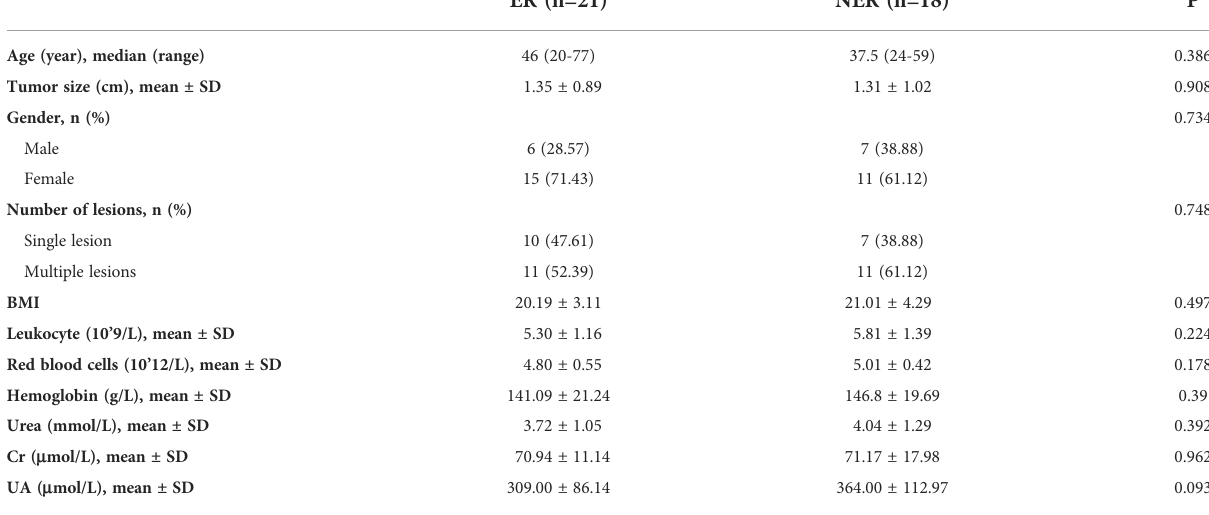
TABLE 1 Comparison of general clinical data of the two groups of